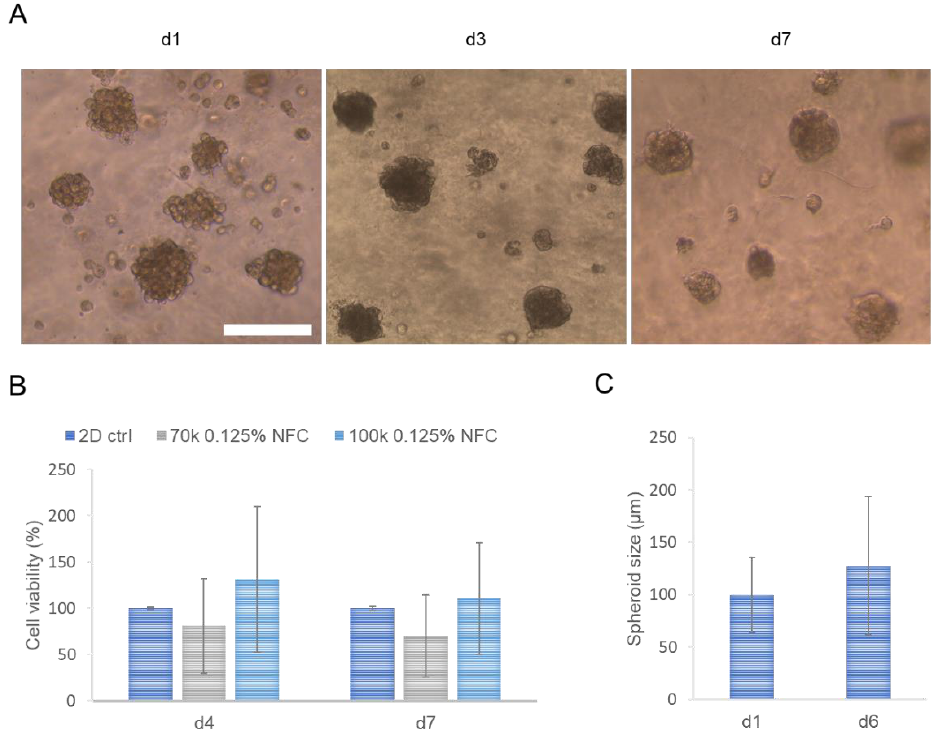
Figure 1. Culturing of human adipose-derived mesenchymal stromal cells (hASCs) in nanofibrillated cellulose (NFC) hydrogel. ( A ) Light microscopy images of hASC spheroids in NFC hydrogel on day 1 (d1), d3, and d7. Scale bar, 200 µm. ( B ) Cell viability of hASCs with cell densities 70,000 (70 k) and 100 k per well cultured in 0.125% NFC hydrogel compared with control two-dimensional (2D) culture on d4 and d7 ( n = 3; 3 technical replicates). ( C ) Measured diameters of hASC spheroids (100 k) in NFC hydrogel on d1 and d6 ( n = 2 – 5; >5 technical replicates). Ctrl, control.